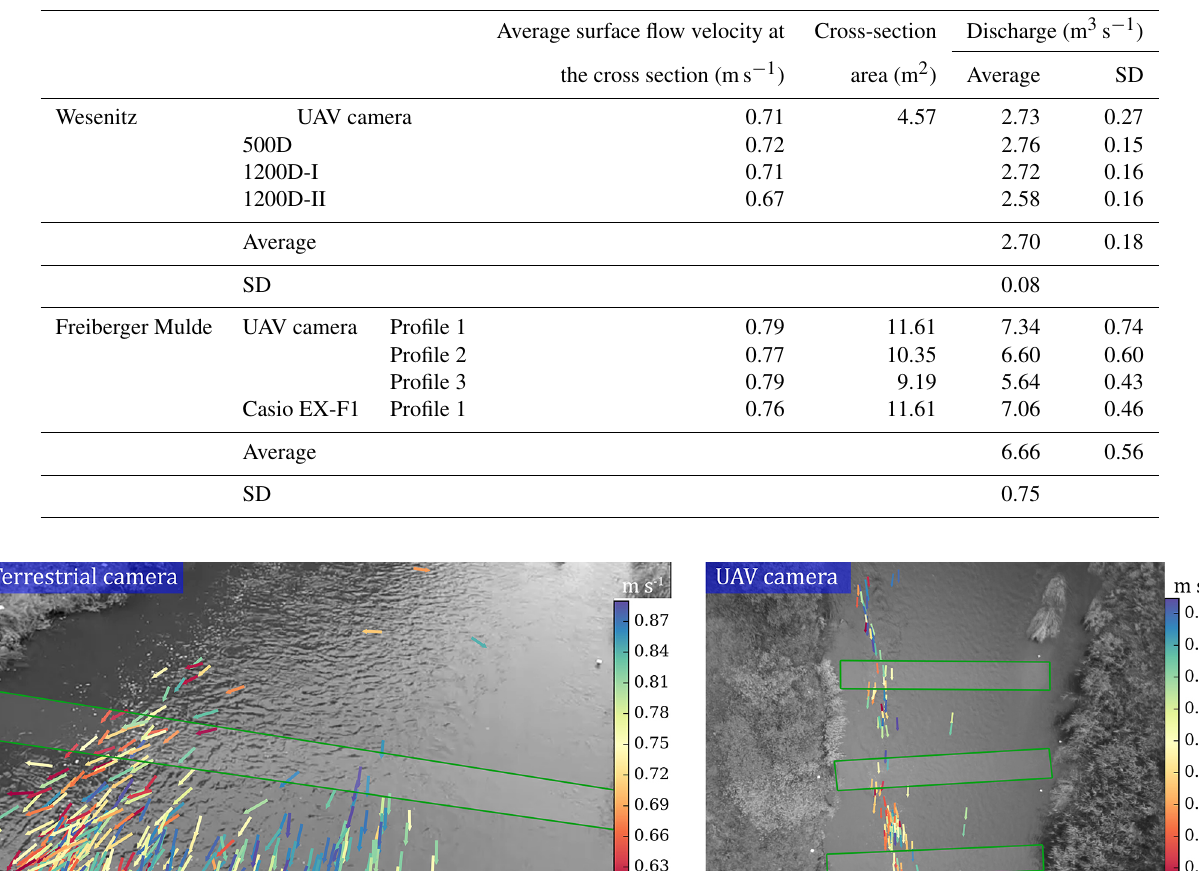
Table 4. Discharge estimated using flow velocities and cross sections retrieved from UAV data.